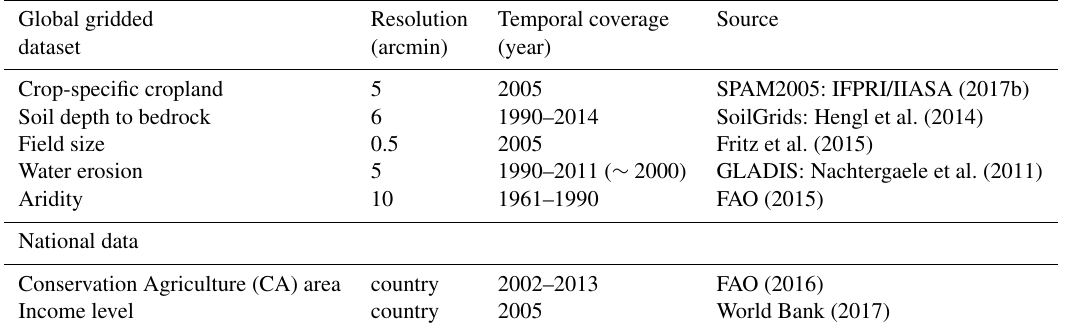
Table 2. Gridded and national-scale datasets used for mapping